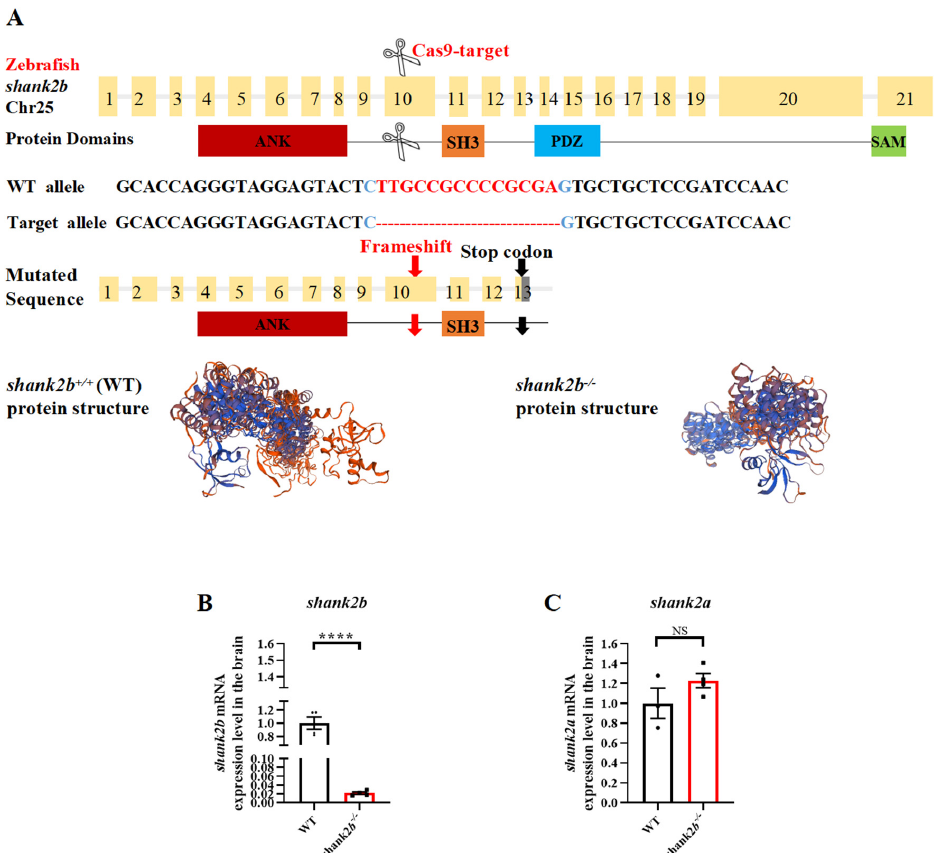
Figure 1. Generation of a zebrafish shank2b mutant using CRISPR/Cas9. ( A ) Structure of zebrafish shank2b gene and protein. The protein domains (ANK, ankyrin repeat domain; SH3, Src homology 3 domain; PDZ, PSD-95/Discs large/ZO-1 domain; SAM, sterile alpha motif domain) are aligned to the corresponding exons. Diagram of target site on 10th exon of zebrafish shank2b genomic DNA and a 14 bp deletion mutation by CRISPR/Cas9 gene editing. Predicted structures of wild-type (WT) and shank2b mutant proteins in zebrafish. The 14 bp deletion resulted in a stop codon on 13th exon and premature termination before the PDZ and SAM domains. ( B ) Reduced expression of shank2b mRNA in the brain of shank2b − / − adult male zebrafish at 4.5 months post-fertilization (mpf) compared to WT fish, analyzed by RT-qPCR (WT n = 4, shank2b − / − n = 4, **** p < 0.0001, Student’s t test). Data are shown as mean ± SEM. ( C ) The expression of shank2a mRNA in the brain of WT and shank2b − / − adult (4.5 mpf) male zebrafish was not affected (WT n = 3, shank2b − / − n = 4, ns, p = 0.1957, Student’s t test). Data are shown as mean ±